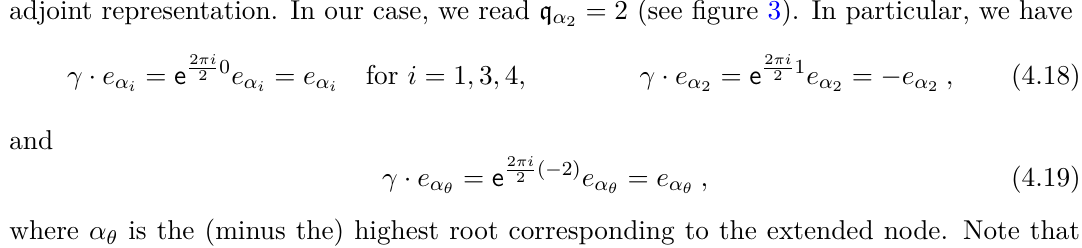
subalgebra of D 1